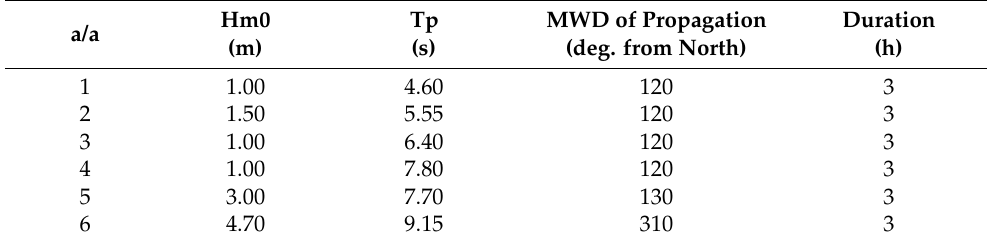
Table 3. Wave scenarios to be